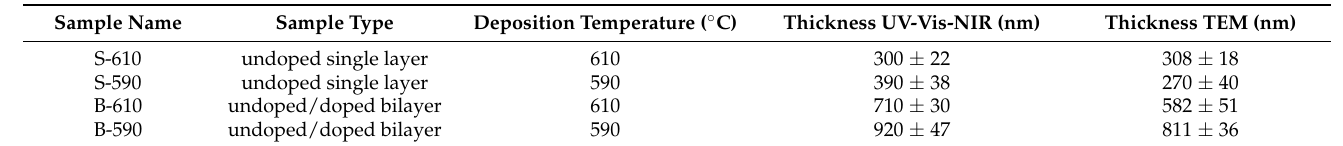
Table 1. SnO 2 layer deposition parameters (doping, deposition temperature), thickness estimated from optical measurement (UV-Vis-NIR transmittance), and